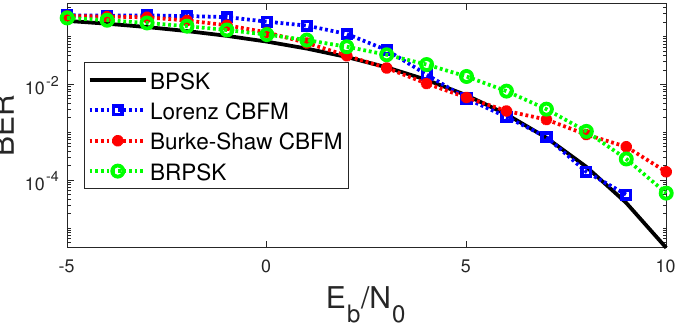
Figure 7. Bit error rate ( BER ) for BPSK, Lorenz CBFM and Burke–Shaw CBFM waveforms, and BRPSK as a function of the ratio of energy per bit to noise spectral density ( E b / N 0